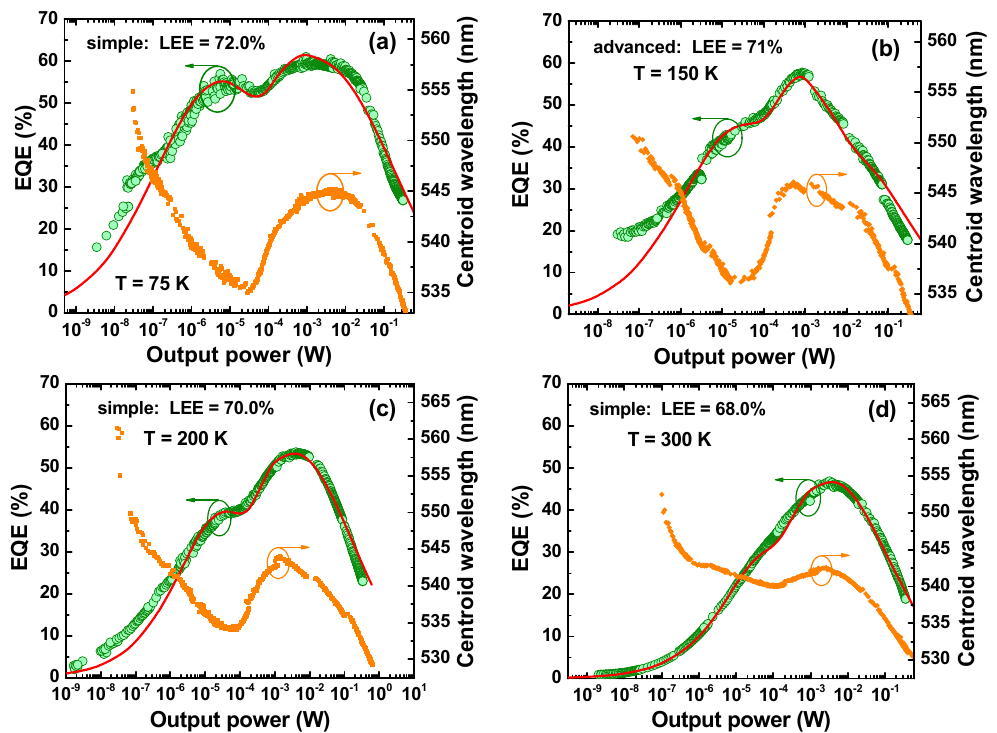
Figure 5. EQE of the green LED and emission wavelength as a function of output power measured at various temperatures (symbols) and predicted by modified ABC-model (solid lines). ( a ) Simple: LEE = 72.0%, T = 75 K; ( b ) advanced: LEE = 71%, T = 150 K; ( c ) simple: LEE = 70.0%, T = 200 K; ( d ) simple: LEE = 68.0%, T = 300